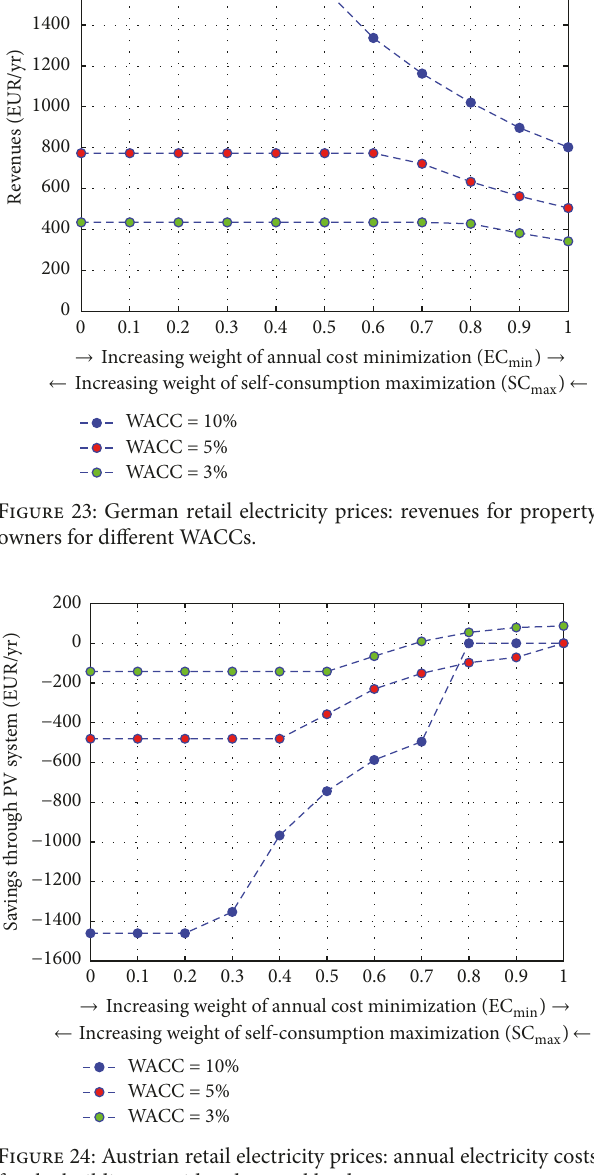
Figure 24: Austrian retail electricity prices: annual electricity costs for the building considered as total load.